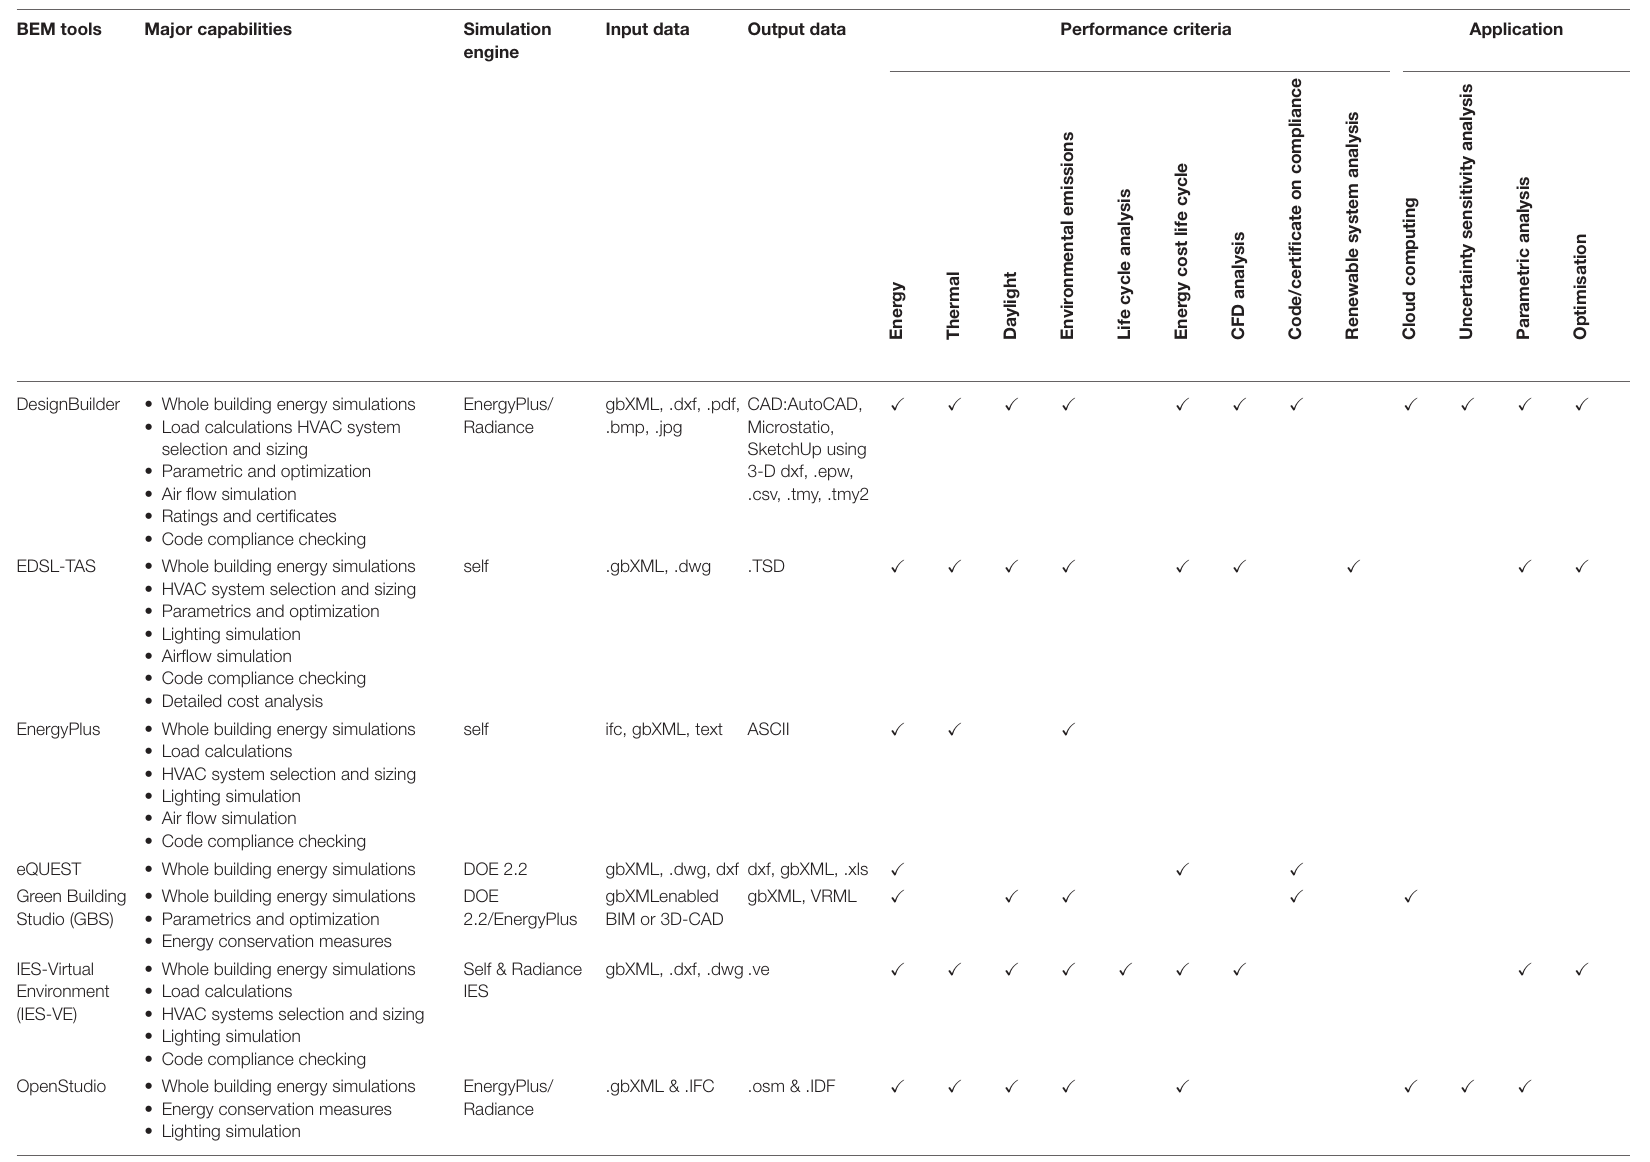
TABLE 1 | Comparison of selected BEM tools (Han et al., 2018; Solmaz, 2019). BEM